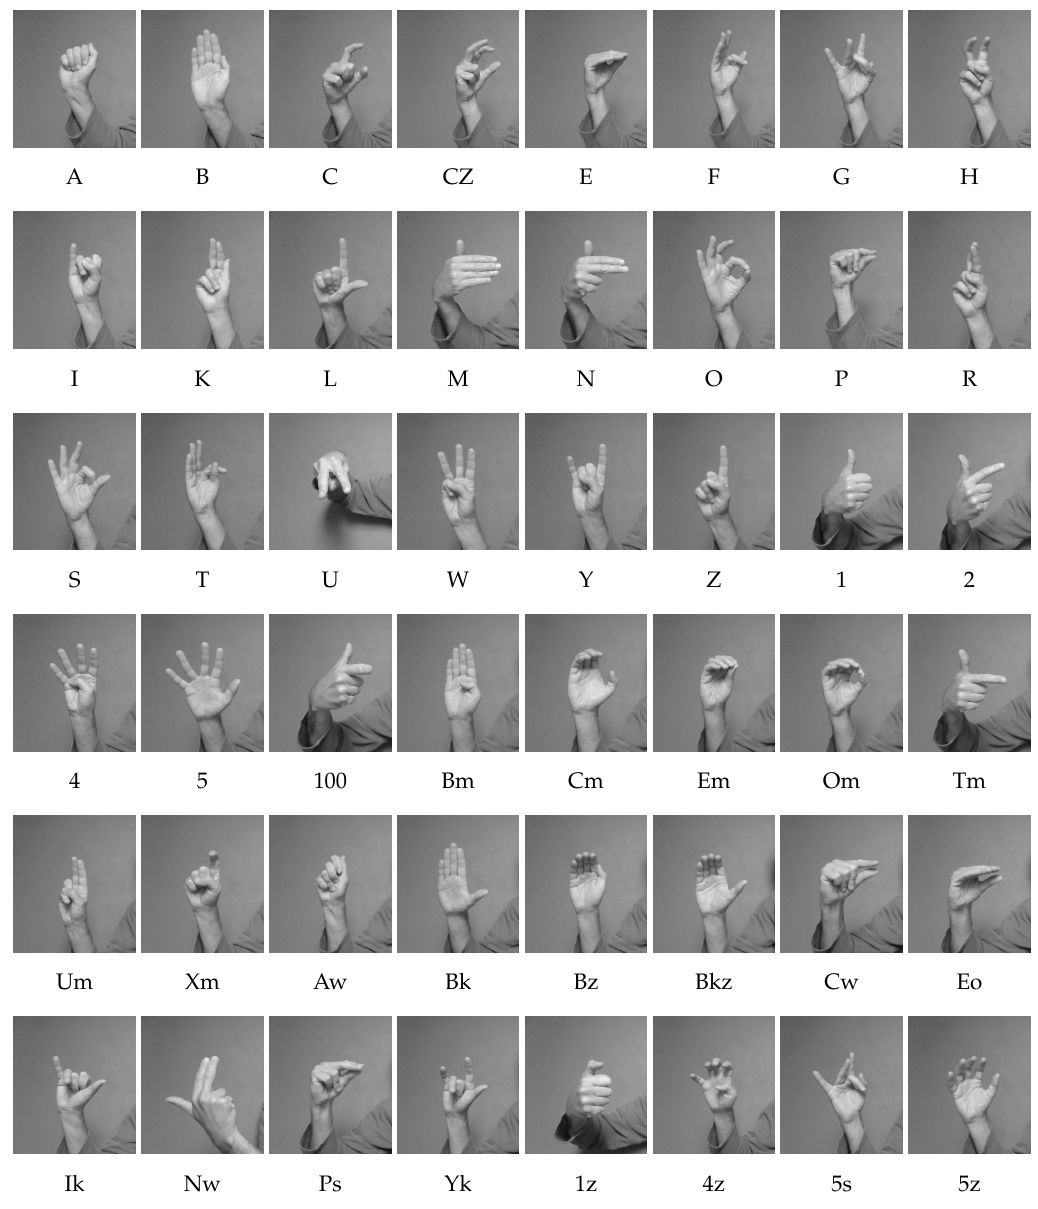
Figure 3. Static handshapes, occurring in Polish Finger Alphabet and Polish Sign